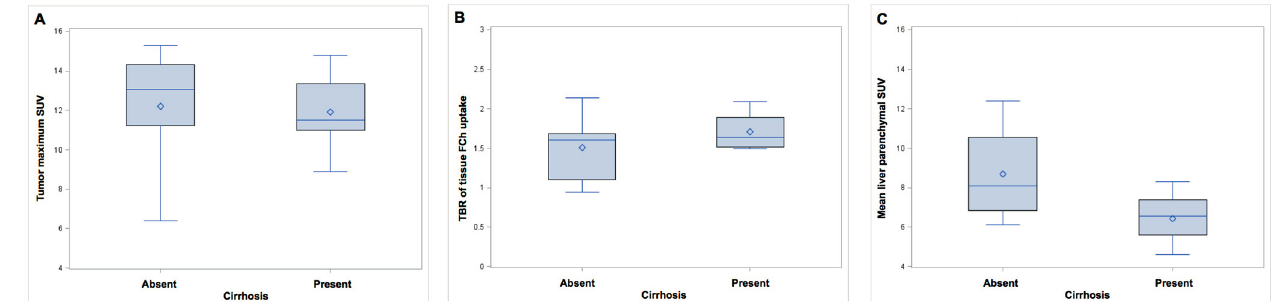
Figure 6. Box-plots of tumor maximum standardized uptake value (SUV) (panel A ), tumor-to-background ratio (tumor-to-background ratio (TBR), panel B ), and mean parenchymal liver SUV (panel C ) in cirrhotic vs. non-cirrhotic HCC patients. Differences in tumor maximum SUV and TBR were not statistically significant. Mean SUV in the liver parenchyma of cirrhotic patients was significantly lower as compared to non-cirrhotic patients (6.4 vs. 8.7, p < 0.05). Upper and lower boundaries of boxes represent the 75th and 25th percentiles, respectively (Interquartile Ranges). Mean values are indicated by diamonds and median values are indicated by horizontal lines within the